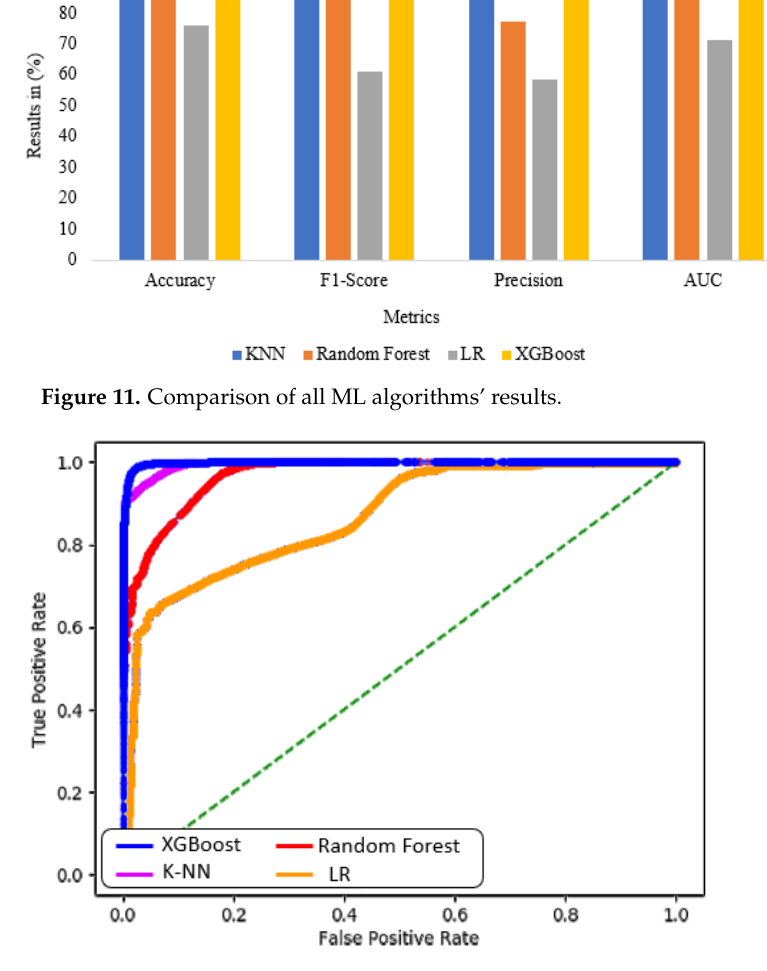
Figure 12. ROC for the applied